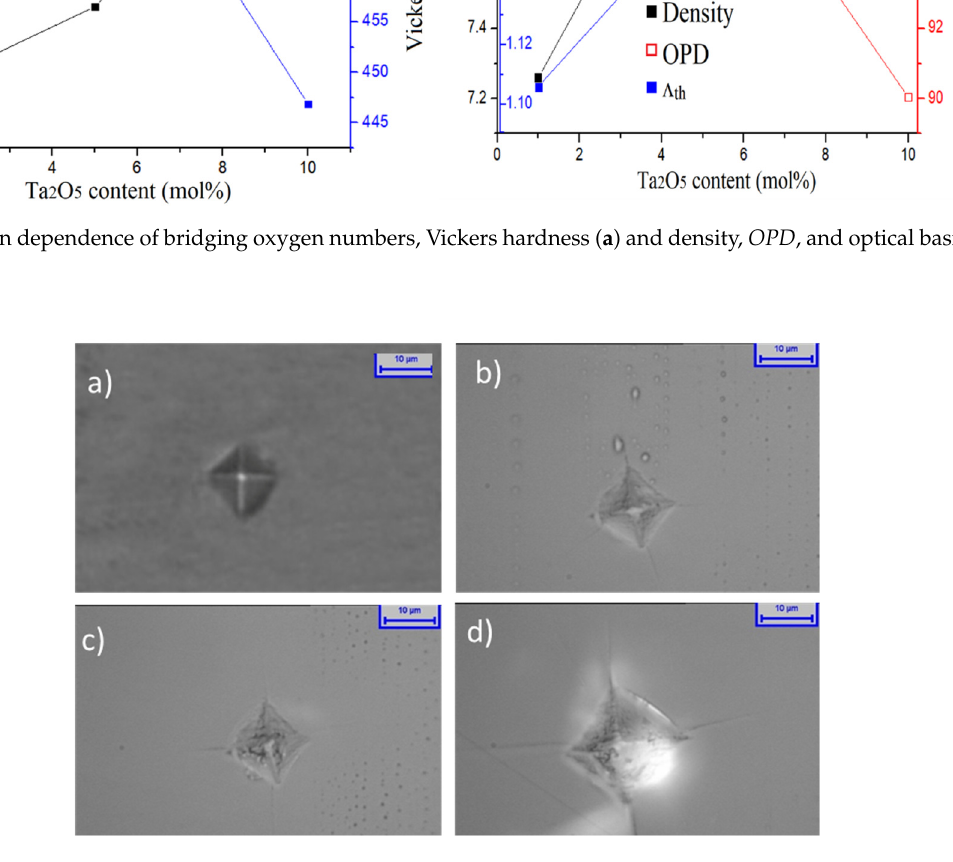
Figure 7. Vickers hardness indentations on the host ( a ), 467.98 HV, PBT 1 ( b ), PBT 5 ( c ), and PBT 10 ( d ).